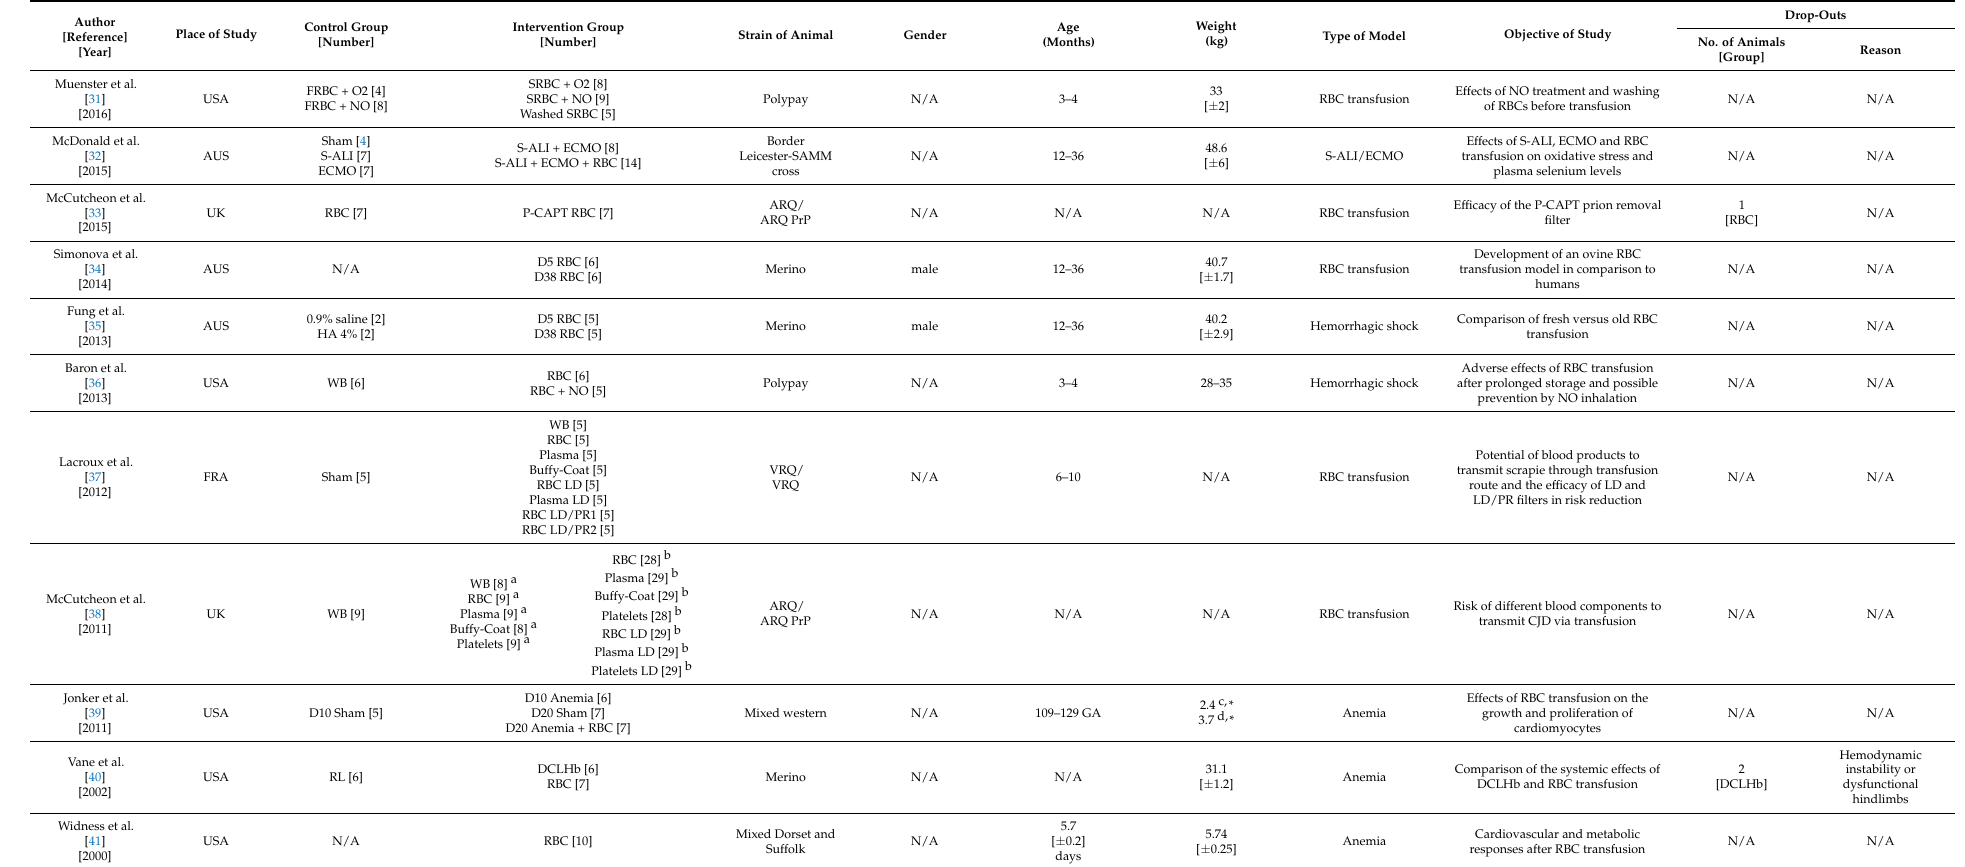
Table 2. Characteristics of included ovine studies (group B), sorted by year of